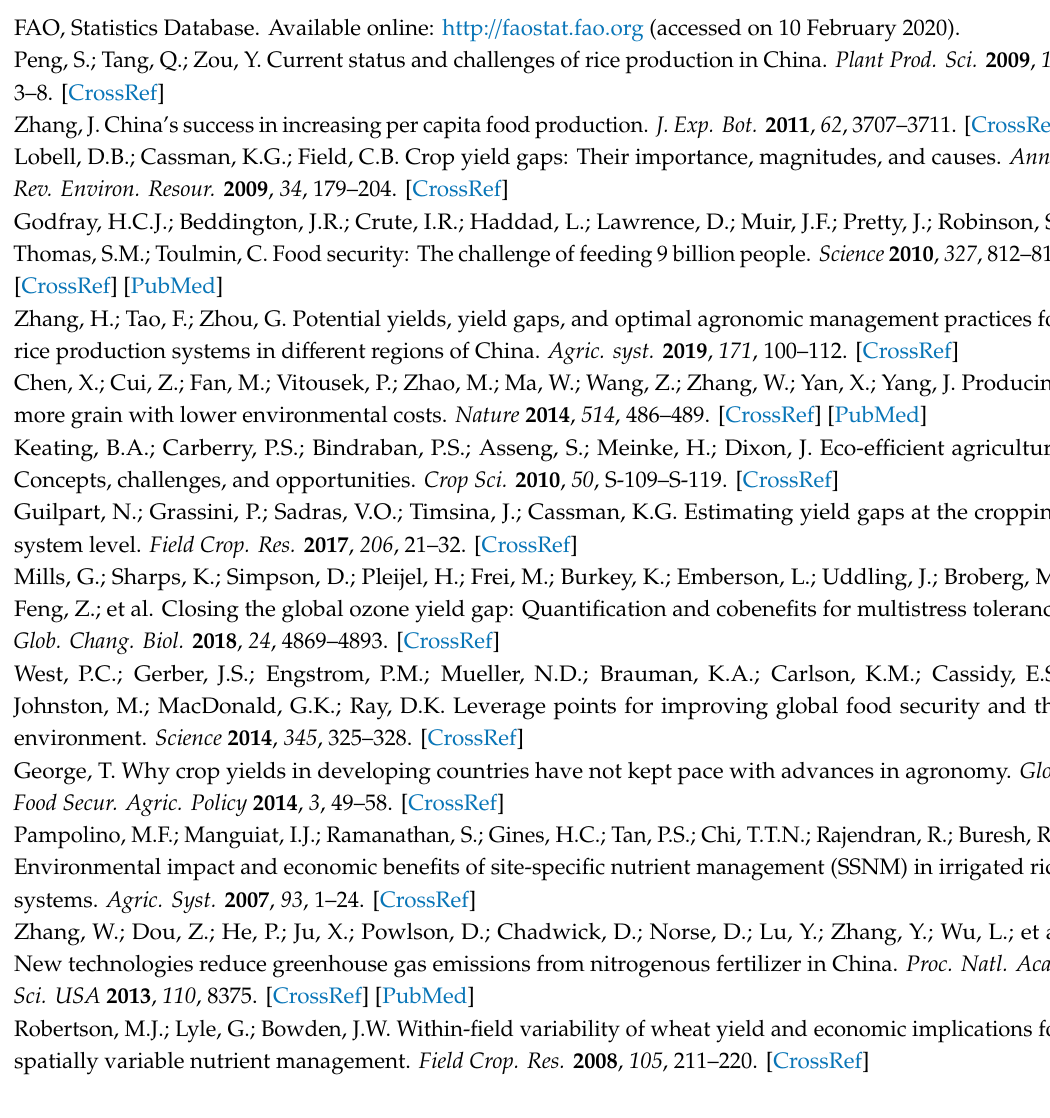
Table S1: The number of samples from farm surveys and published studies used in this study. Table S2: Average grain yield, partial factor productivity of applied N (PFP N ) and nitrogen (N), phosphorus (P 2 O 5 ) and potassium (K 2 O) application rates from farmer surveys conducted from 2008 to 2014 in Jiangsu province. Table S3: Household and plot characteristics of farmers in Jiangsu province surveyed from 2008 to